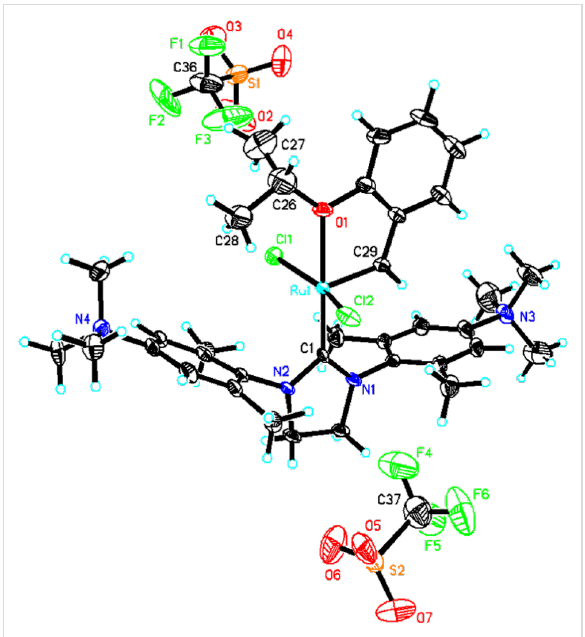
Figure 2: Single crystal X-ray structure of Ru-2 . Co-solvent and disor- dered triflates have been omitted for clarity.